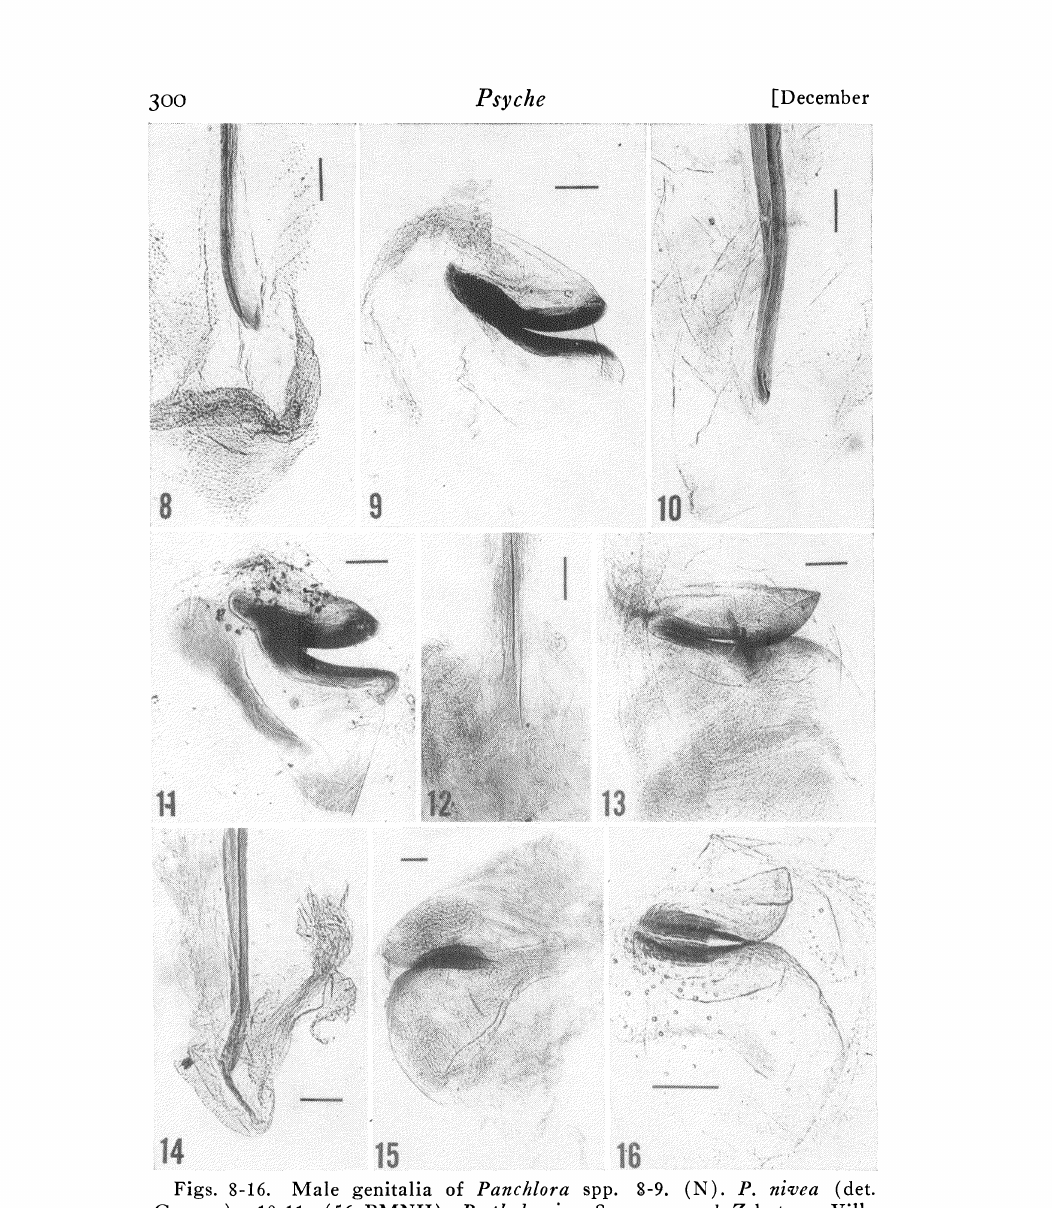
Figs. 8-16. Male genitalia of Panchlora spp. 8-9. (N). P. niea (det. Gurney). 10-11. (56 BMNH). P. thalassina Saussure and Zehntner. Villa Ana, F.C.S.F. Argentina (det. Hebard). 12-13. (173 USNM). P. sp. Palenque, Chiapas, Mexico. 14-15. (172 USNM). P. sp. Palenque, Chiapas, Mexico. (15 is a ventral view). 16. (57 BMNH). P. bidentula Hebard. Mosqueiro, Rio de Para (det. Hebard). (scale 0.1